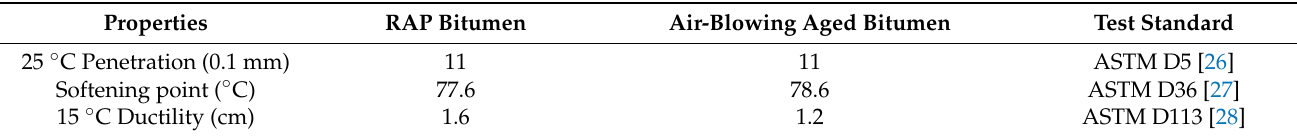
Table 3. Conventional properties of RAP binder and artificial-aged bitumen.